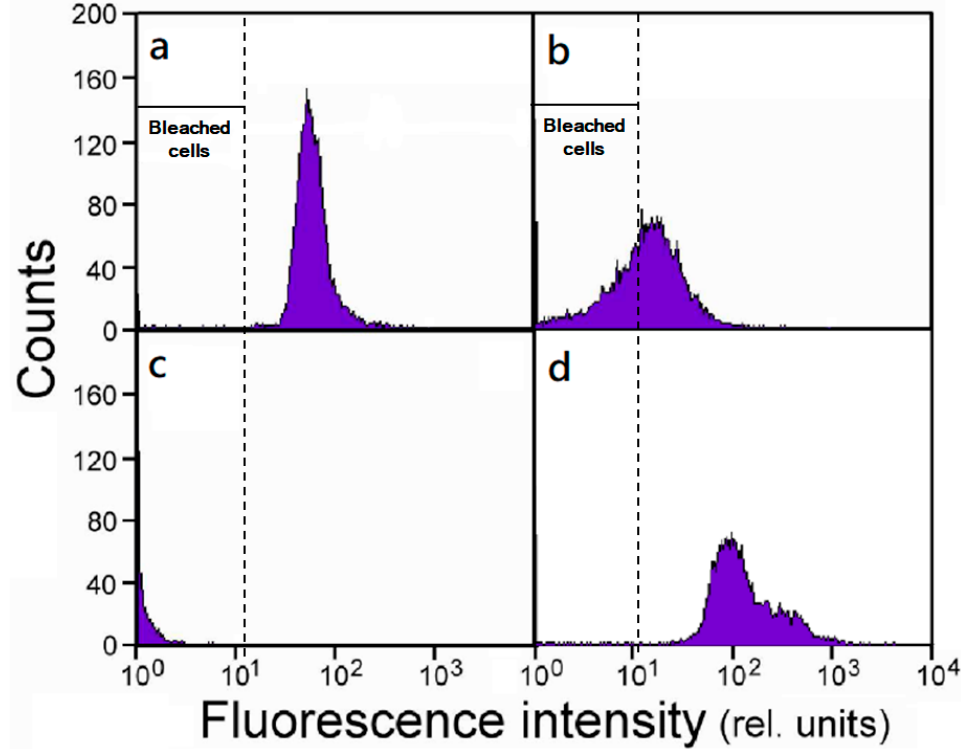
Figure 1. The frequency distribution histograms of Scenedesmus cells analyzed for chlorophyll a fluorescence. ( a ) Untreated synchronous small cells, and the cells that had been heat treated (46.5 °C, 1 h) and then cultured under illumination for ( b ) 6 h, ( c ) 24 h, and ( d ) 96 h. A fluorescence intensity lower than 20 are identified as bleached cells. Three independent measurements were conducted at each time point.